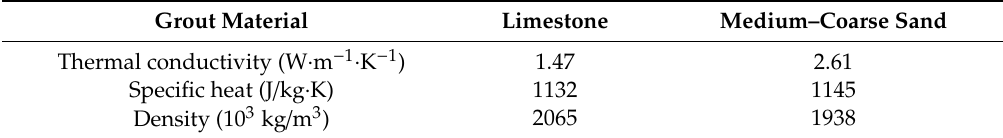
Table 3. Properties of backfill grout materials.